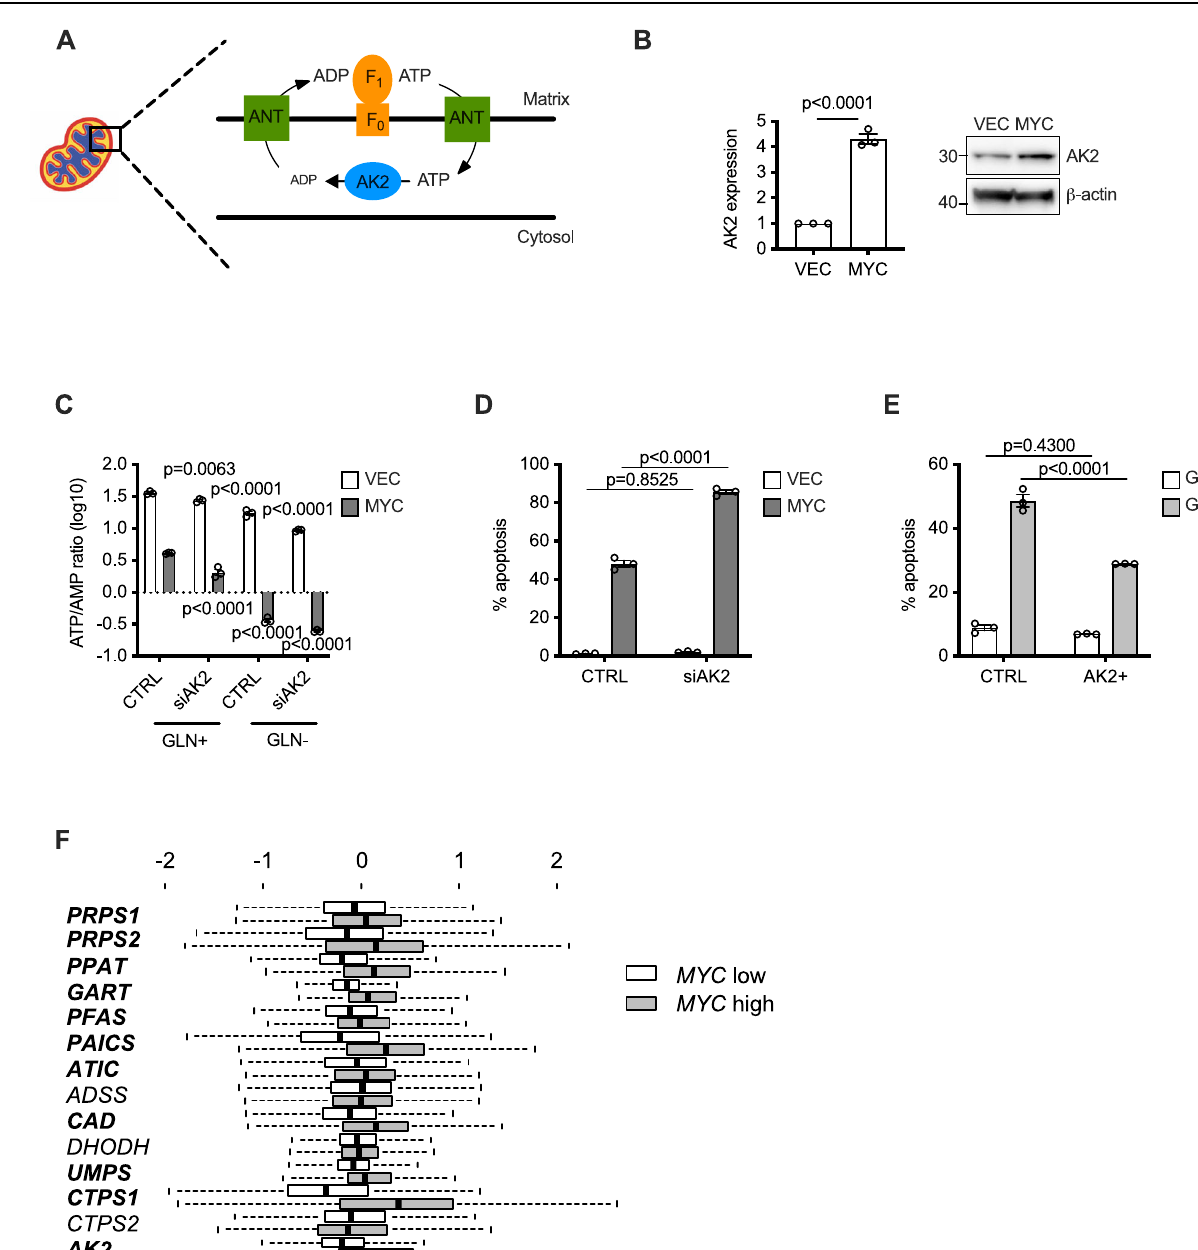
Fig. 7 | Facilitation of mitochondrial energy generation by AK2 limits MYC- induced apoptosis. A Schematic of the nucleotide environment in the mito- chondrial intermembrane space where AK2 is located. B Induction of AK2 expres- sion by MYC shown by qRT-PCR (left panel) and western blot (right panel). Statisticalanalysiswascarriedouton n =3replicatesusinganunpairedtwo-tailed t test. C RatioofpeakintensitiesofATP/AMPofMYCcellswithknockdownofAK2as measuredbyLC-MS.Anordinaryone-wayANOVAwasusedtodeterminestatistical signi fi cance( n =3biologicalreplicates). D , E AnnexinV/PIassaysinMRC-5cellswith ( D ) siRNA-mediated knockdown and ( E ) overexpression of AK2. An ordinary one- way ANOVA was used to determine statistical signi fi cance ( n =3 biological